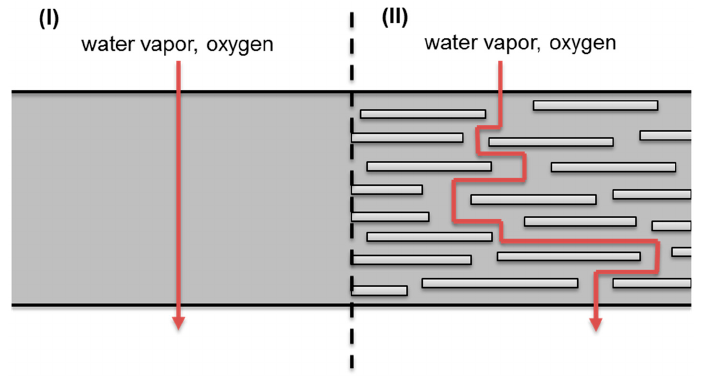
Figure 6. “Tortuous pathway” created by incorporation of exfoliated clay nanoplatelets into a polymer matrix film. In a film composed only of polymer (I), diffusing gas molecules on average migrate via a pathway that is perpendicular to the film orientation in a nanocomposite (II), diffusing molecules must navigate around impenetrable particles/platelets and through interfacial zones which have different permeability characteristics than those of the virgin polymer. Adapted from